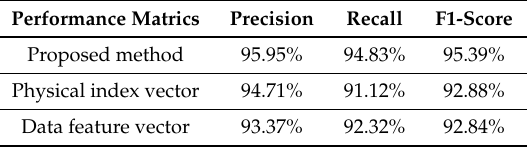
Table 4. Prediction performance of aged